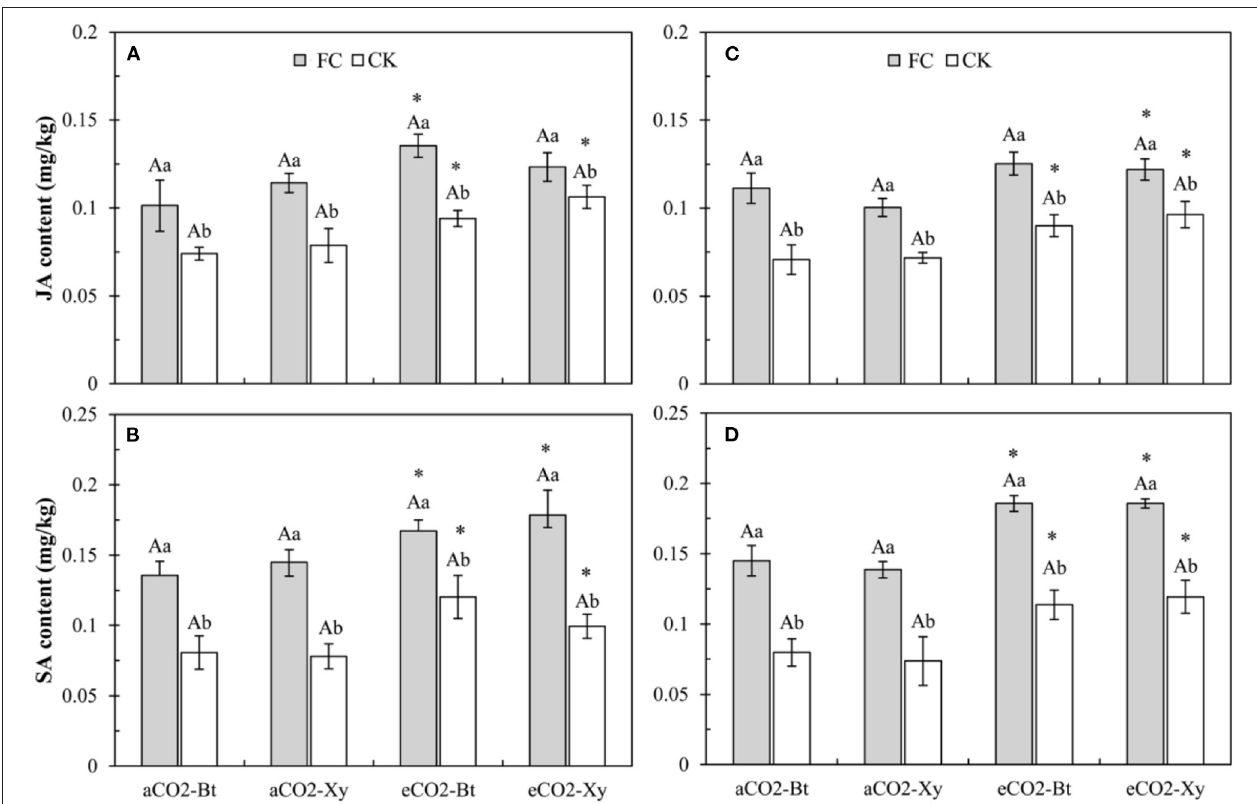
FIGURE 3 | Effects of the inoculation with arbuscular mycorrhizal fungi (AMF), F. caledonium, on the foliar JA and SA contents of Bt maize (Bt) and its parental line of non- Bt maize (Xy) under ambient CO 2 ( a CO 2 ) and elevated CO 2 ( e CO 2 ) at the heading stage (BBCH-59) in 2017 (A,B) and 2018 (C,D) . (Note: FC, F. caledonium inoculation; CK, the control without F. caledonium inoculation; a CO 2 -Bt, Bt maize under a CO 2 ; a CO 2 -Xy, non- Bt maize under a CO 2 ; e CO 2 -Bt, Bt maize under e CO 2 ; e CO 2 -Xy, non- Bt maize under e CO 2 ; Different uppercase, lowercase letters and * indicate significant difference between Bt maize and non- Bt maize, between F. caledonium inoculation and non-inoculation of F. caledonium, and between a CO 2 and e CO 2 under the same other conditions as revealed by Tukey’s test, the same